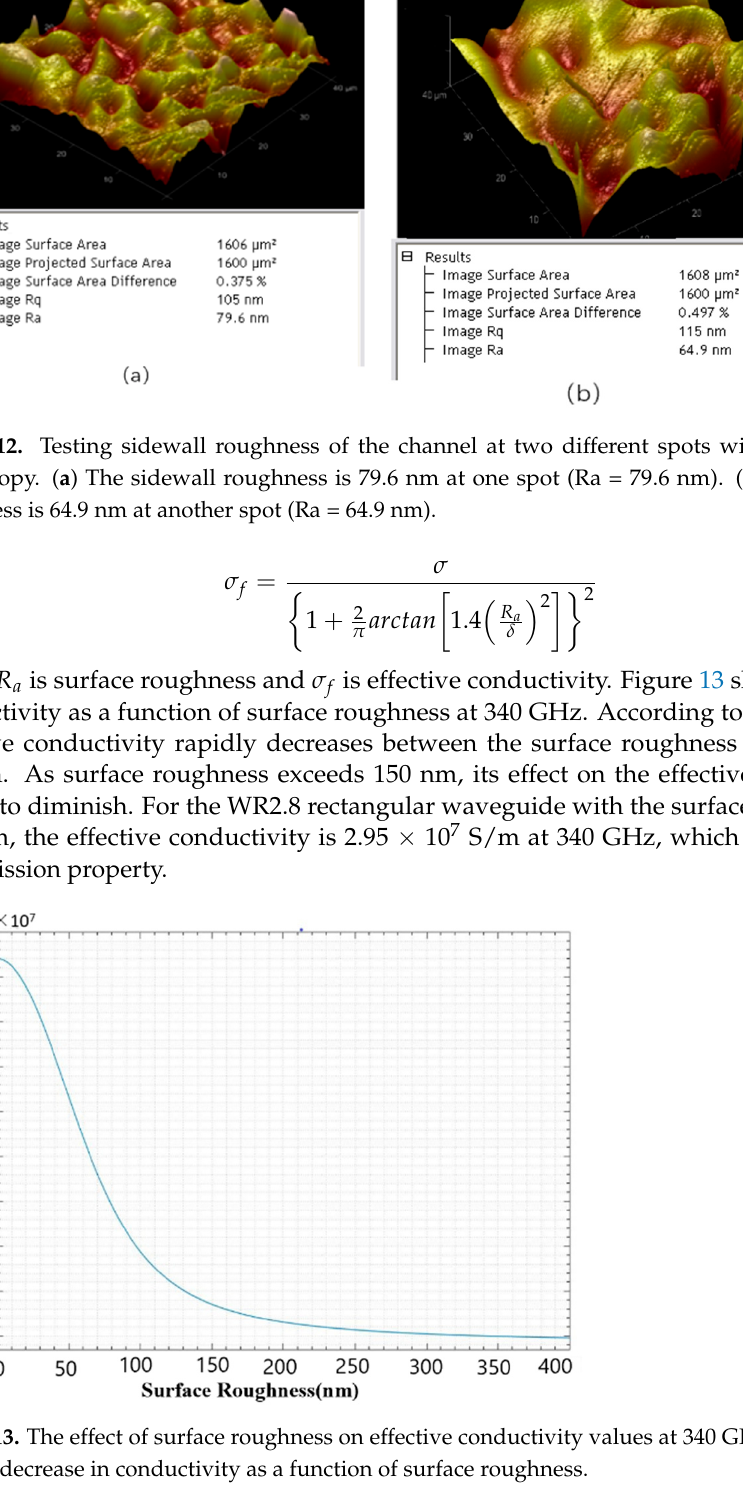
Figure 14. The model of the WR2.8 waveguide used in the CST calculation. The copper conductivity was set as 2.95 × 10 7 S/m in calculation. The simulated S 21 for the TE10 mode was about − 0.58 dB over the band. We also measured the S 21 parameter using the two ‐ port vector network analyzer. The flanges of the WR2.8 waveguide were used to connect flanges on the test fixture and fixed by screws. The experimentally measured S 21 was from − 2.3 dB to − 2.9 dB. As shown in Figure 15, by comparing the measured and simulated results, the measured S 21 was − 2 dB less than the simulated one, caused by test errors, and mainly produced by the small dimensional tol ‐ erance and mechanical alignment. Figure 16 shows the S 11 parameters of the waveguide. From the figure, it can be seen that the measured S 11 parameters ranged from − 16 dB to − 48 dB, while the calculated S 11 parameter was about − 85 dB. Further work should be car ‐ ried out to improve the assembly accuracy of waveguides and flanges and the precision of flanges, reducing electrical reflection from a mated pair of flanges.